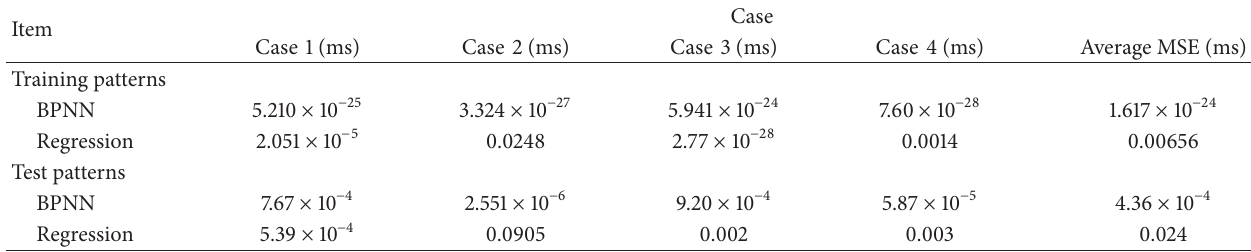
Table 4: MSE of time duration by BPNN and regression